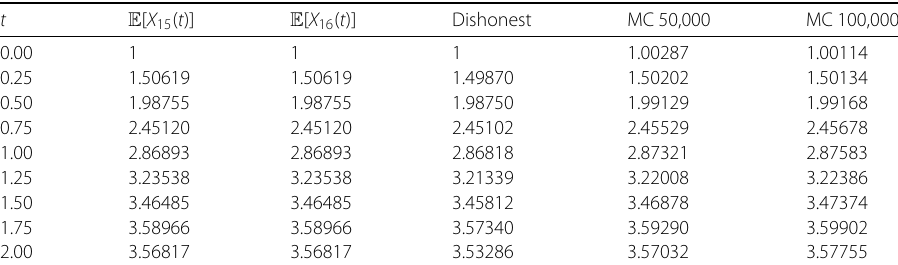
Table 4 Approximation of the expectation of the solution stochastic process. Example 4.1, assuming dependent random data